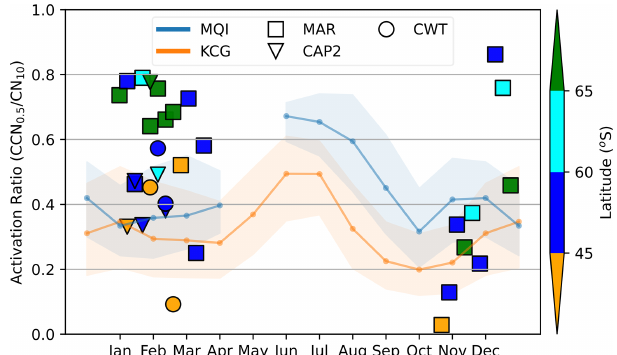
Figure 3. Seasonal cycle of the activation ratio, CCN 0 . 5 / CN 10 , at both Macquarie Island and Kennaook / Cape Grim, with monthly medians (solid line) and interquartile range (shaded regions) shown. Overlaid on seasonal cycles are weekly medians from voyages where data are available, as in Fig.